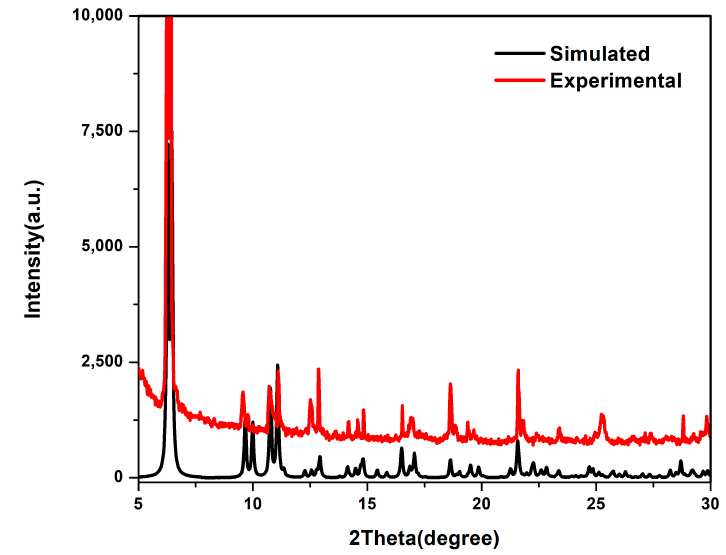
Figure 3. The powder XRD patterns and the simulated pattern from the single-crystal diffraction data for the complex 1 .